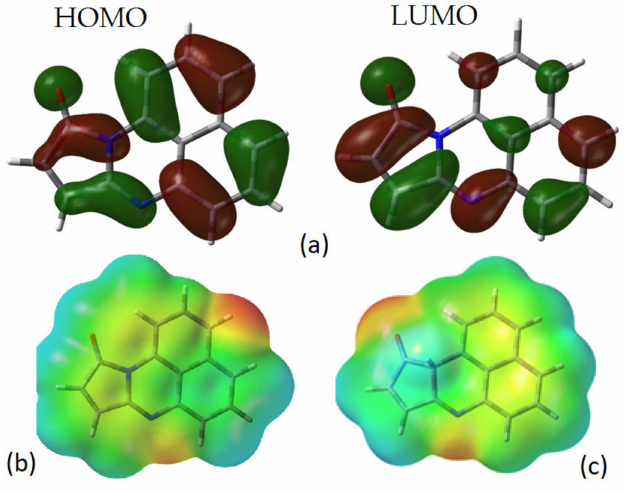
Figure 4. ( a ) Structure and frontier molecular orbitals HOMO and LUMO and ( b ) Electrostatic potential mapped on the electron density for MP and ( c ) analogue of MP with a methyl instead of nitrogen